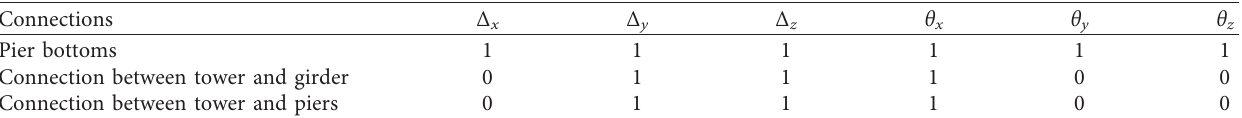
Figure 7: The layout of the connection structures. (a) The connection structures between beam and piers. (b) The connection structures between beam and pylon. Table 1: Boundary conditions in the FE